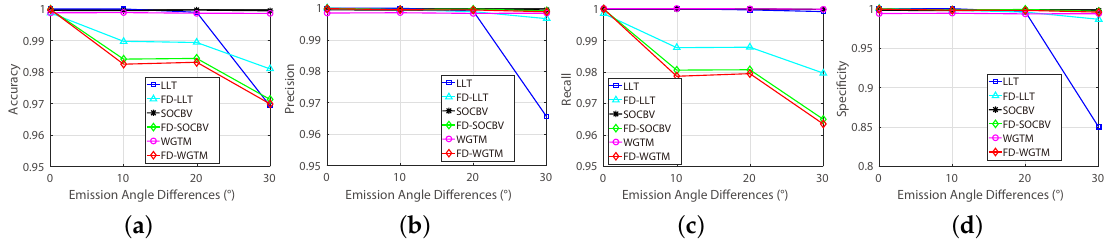
Figure 11. Automatic evaluation results of the three algorithms on datasets with various differences of emission angles. ( a ) Accuracy. ( b ) Precision. ( c ) Recall. ( d )